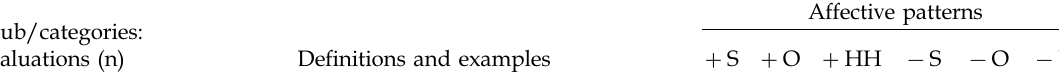
Table 2. Material inheritance: v aluations’ sub/categories and affecti v e